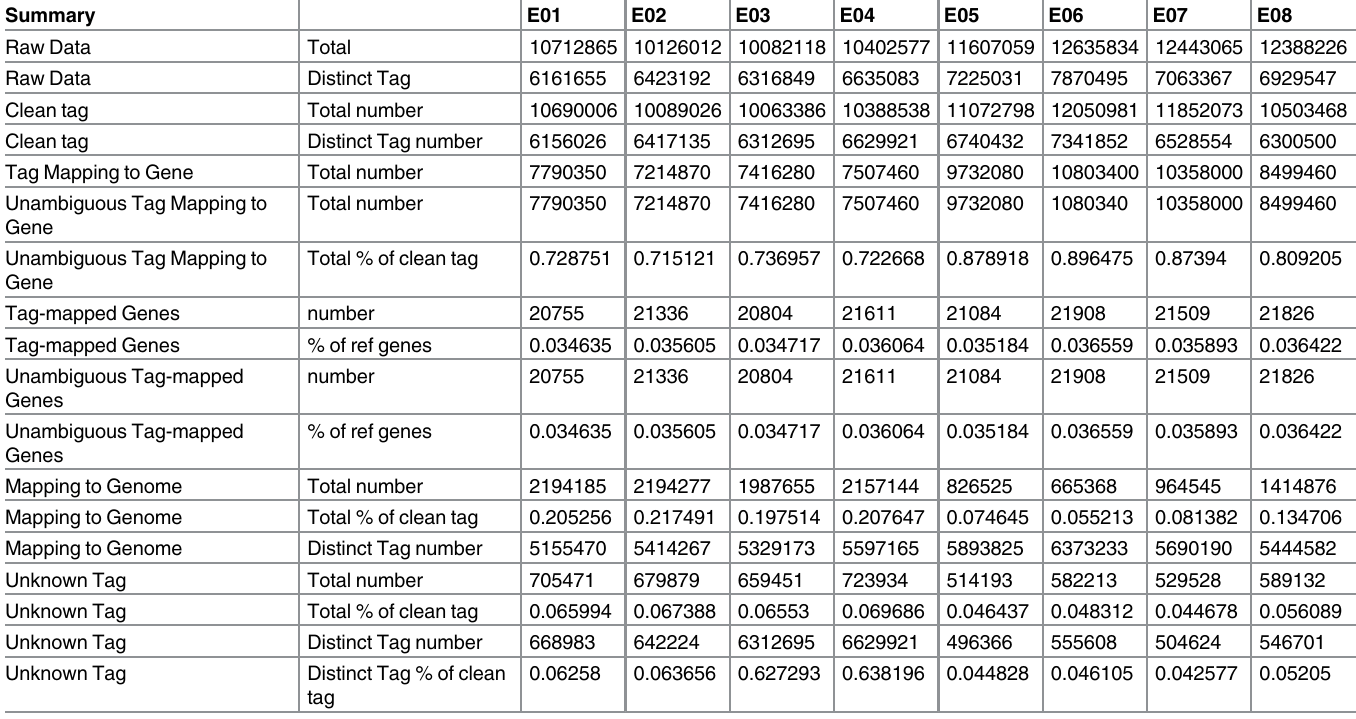
Table 1. Categorization and abundances of DGE tags.